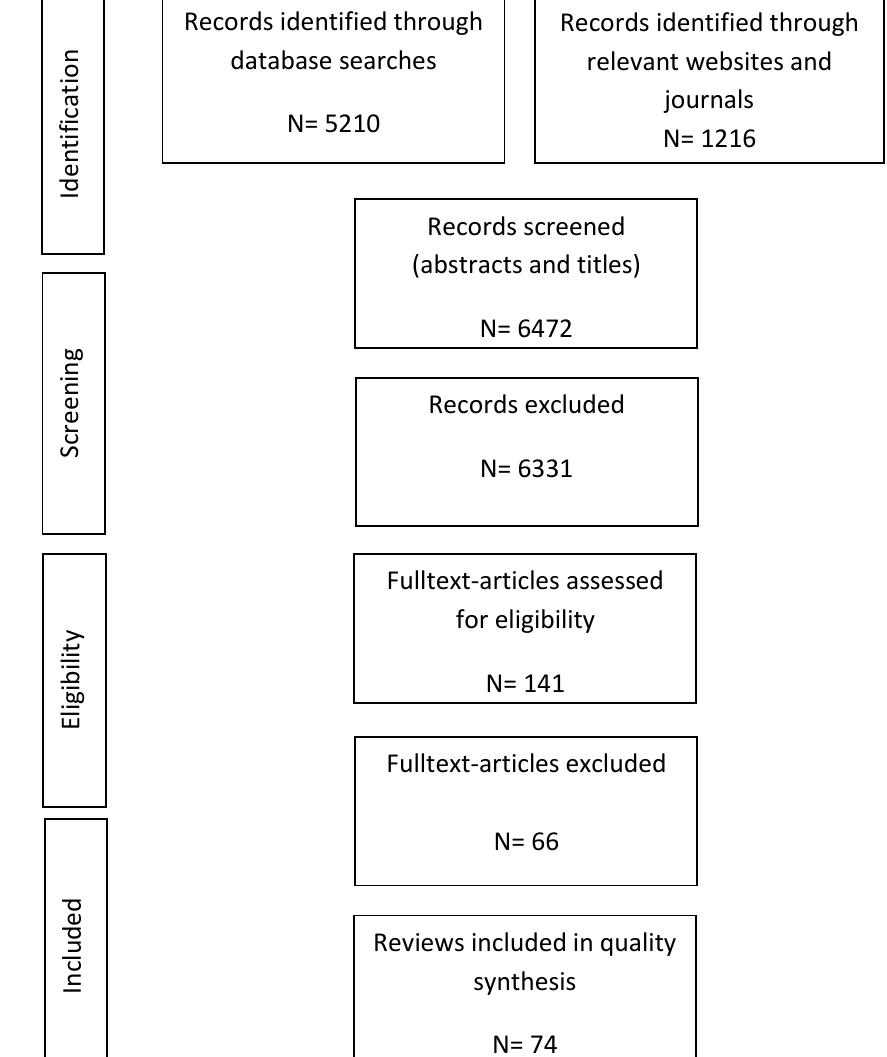
Figure 1. Flow chart of reviews included.